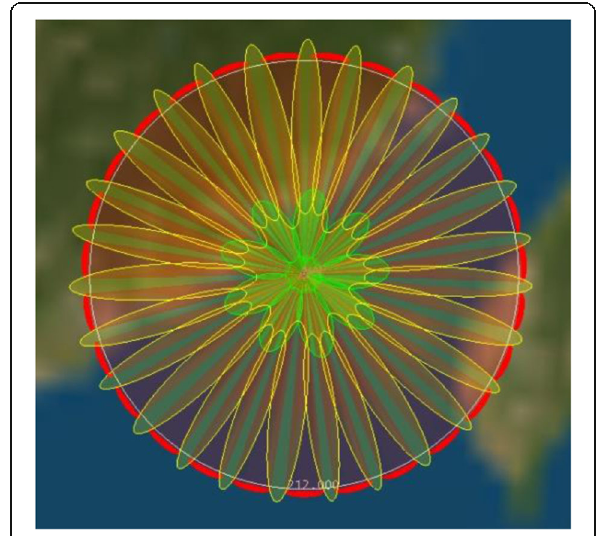
Fig. 7 Schematic diagram of a three-platform four-layer ring cell waveform with a single platform at 5° elevation angle (55 beams)